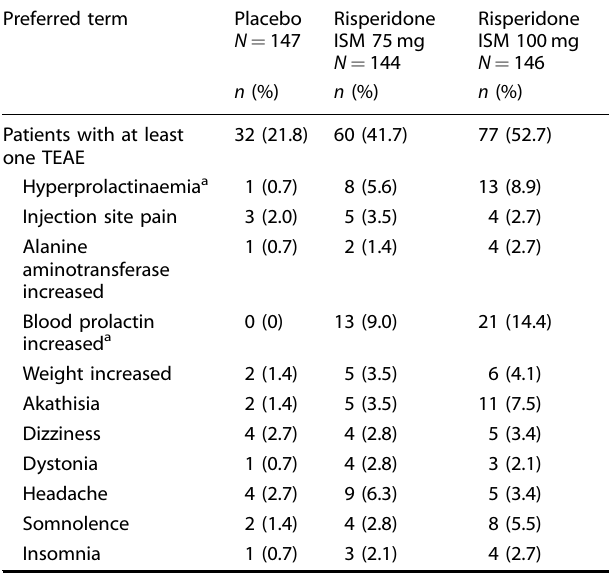
Fig. 4 Overall response rate at each time point (mITT Population). Where the responders are those patients who achieved a decrease from baseline in PANSS Total Score >30% or CGI-I at least much improved. Dropouts prior to a presented time point are treated as non-responders and those patients who do not achieve a response are censored on the day of withdrawal/completion from the treatment. Presented statistics, frequencies, and denominator used for percentages are based on all patients in the ITT population and the randomized treatment. * p < 0.01, ** p < 0.0001. Table 3. Summary of treatment-related TEAEs (safety population).